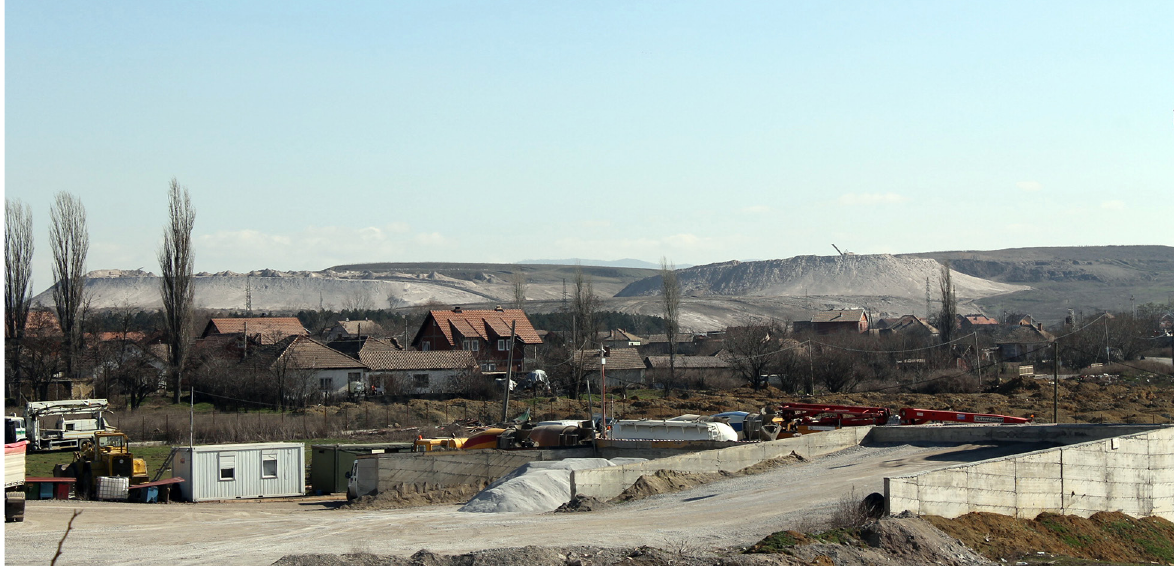
Fig. 8. Mismanagement of ash dumps. Source: V.